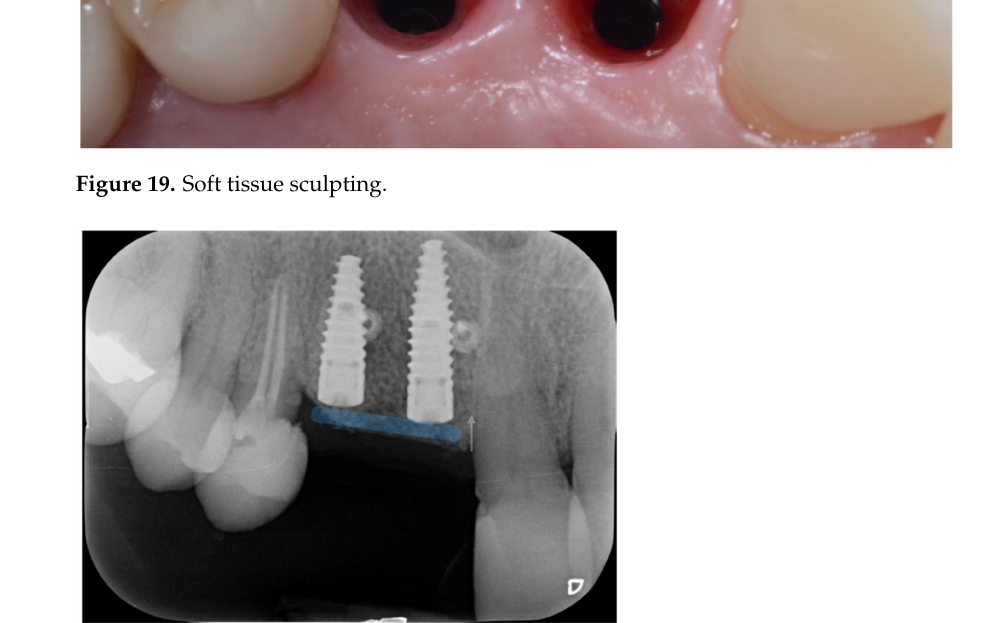
Figure 20. The supra-crestal component of the bone lamina (blue) and the GTR effect near tooth 11 (white